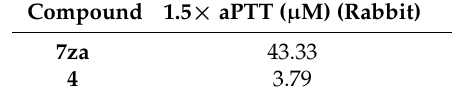
Table 2. The anticoagulant activity of 7za